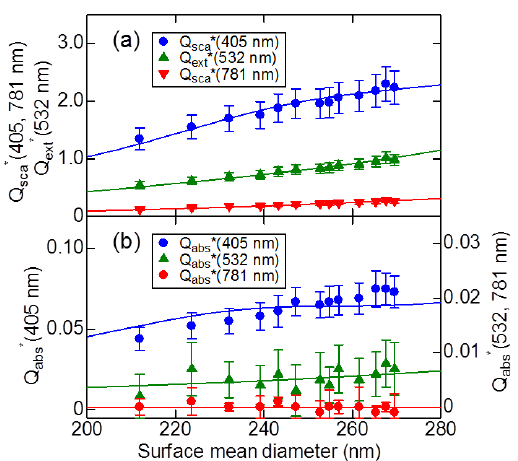
848 Figure 3. Dependence of the effective (a) scattering (or extinction) and (b) absorption 849 Fig. 3. Dependence of the effective (a) scattering (or extinction) and efficiencies of the polydisperse SOA particles on the surface mean diameter at wavelengths of 850 (b) absorption efficiencies of the polydisperse SOA particles on the 405 (circles), 532 (triangles), and 781 nm (inverted triangles) for the toluene-SOAs generated 851 surface mean diameter at wavelengths of 405 (circles), 532 (trian- gles), and 781nm (inverted triangles) for the toluene-SOAs gener- in “run A4”. Error bars indicate the estimated uncertainties for the determination of the 852 ated in “run A4”. Error bars indicate the estimated uncertainties for Q sca * (or Q ext *) and Q abs * values. The solid lines indicate Q sca * (or Q ext *) and Q abs * 853 the determination of the Q sca * (or Q ext *) and Q abs * values. The calculated using Mie theory with the optimized RI values. The definitions of Q sca *, Q ext *, 854 solid lines indicate Q sca * (or Q ext *) and Q abs * calculated using and Q abs * are stated in the text. 855 Mie theory with the optimized RI-values. The definitions of Q sca *, Q ext *, and Q abs * are stated in the text.